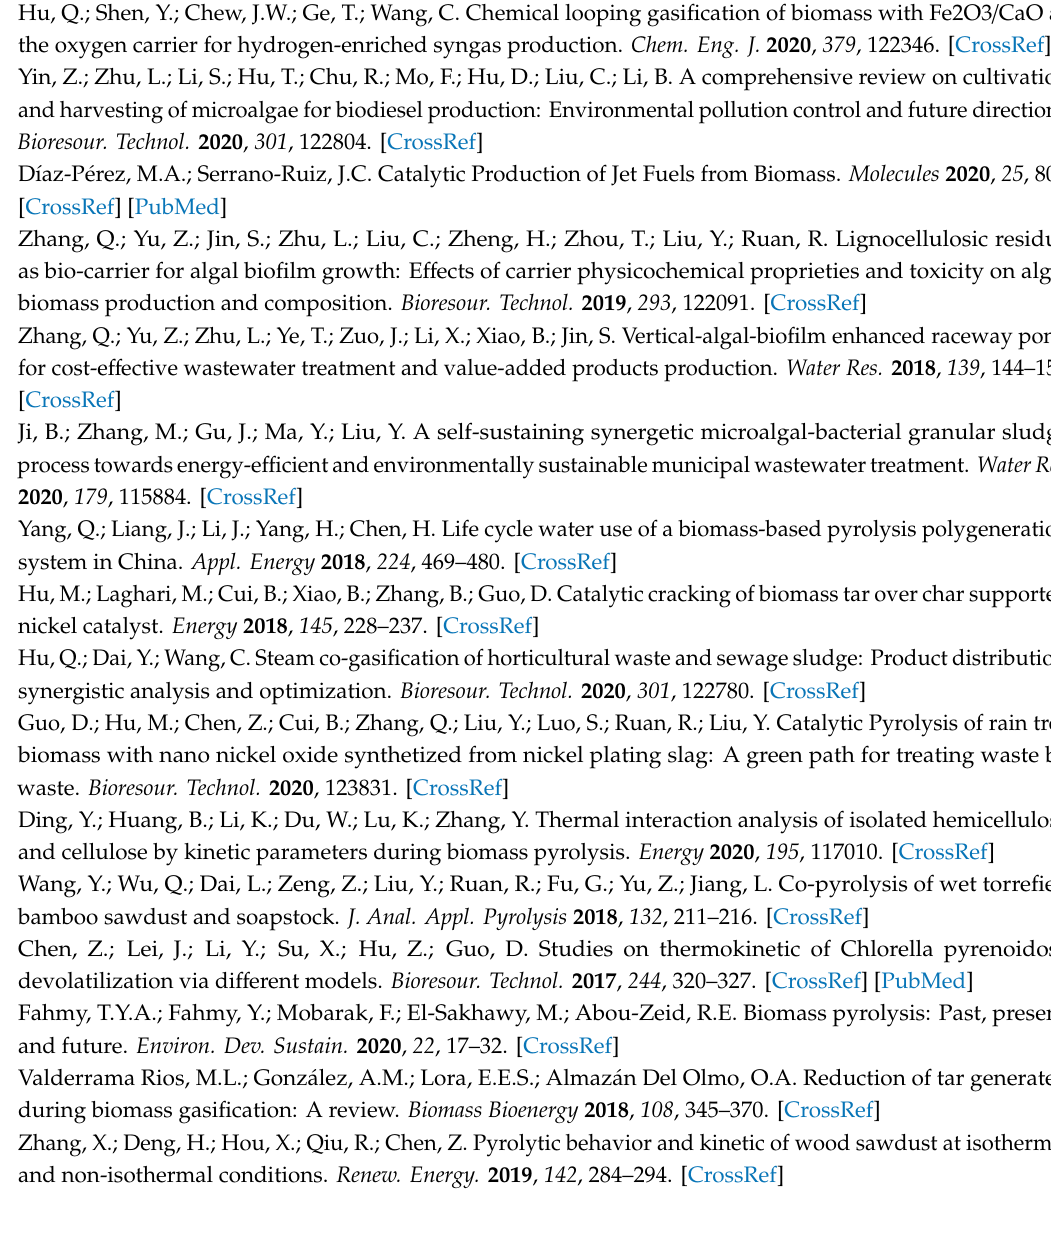
Figure S1: SEM-EDS of di ff erent fresh catalysts. (a) char, (b) Fe-Ni / char. Figure S2: Pore size distributions and nitrogen adsorption-desorption isotherms of di ff erent fresh catalysts. (a) char, (b) Fe-Ni / char. Table